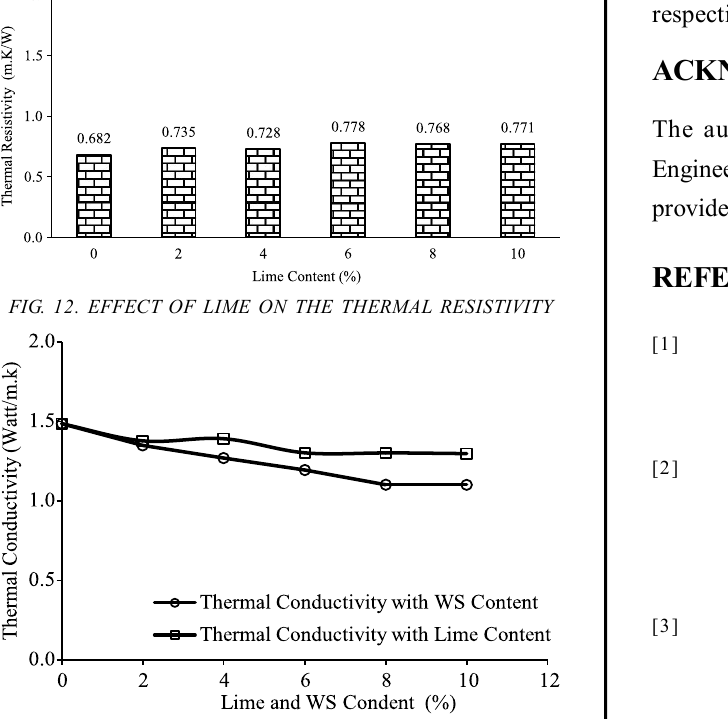
FIG. 13. EFFECT OF LIME AND WHEAT STRAW CONTENT ON THE THERMAL CONDUCTIVITY OF